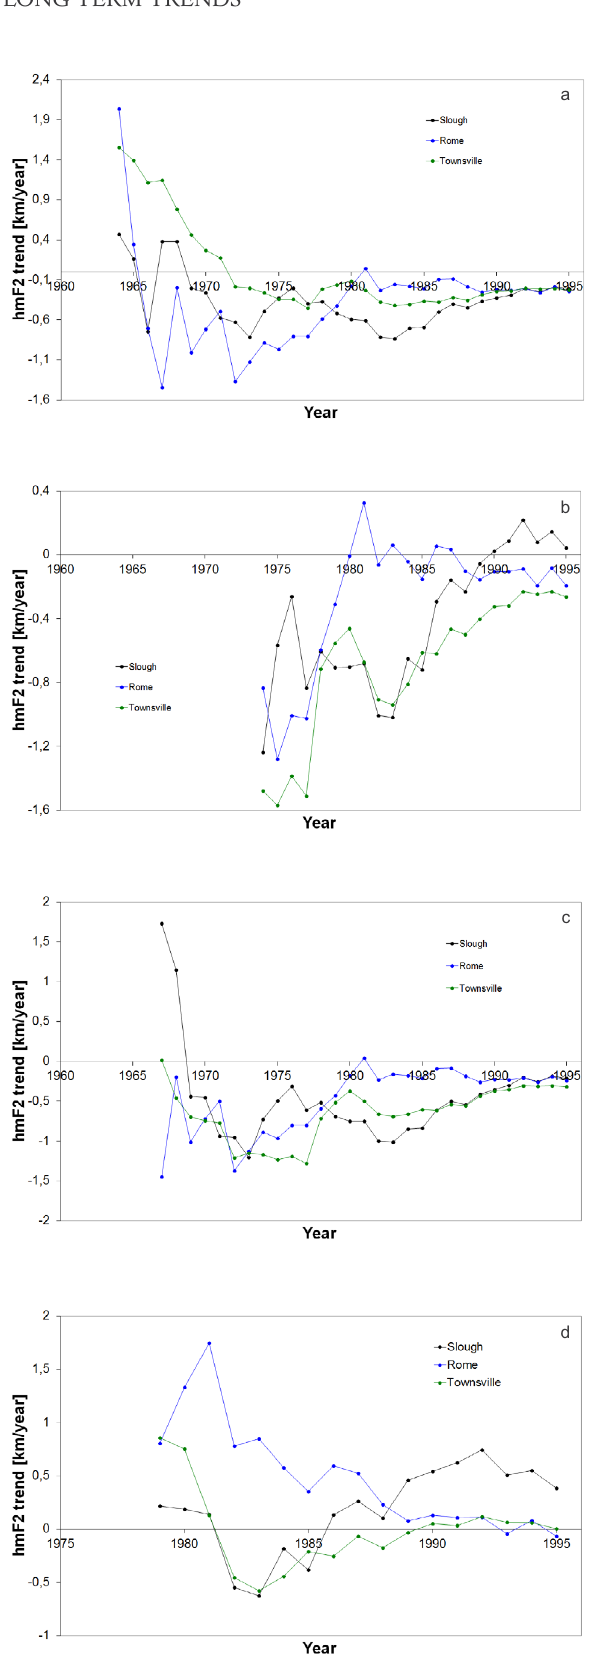
Figure 4. hmF2 trend estimated for hmF2 residual time series start- ing during (a) 1954 solar minimum, (b) 1964 solar minimum, (c) 1957 solar maximum, (d) and 1969 solar maximum considering the first 10 years and then adding the following year for a new data and adding one year at a time. The year corresponding to each trend value is the final year considered for trend